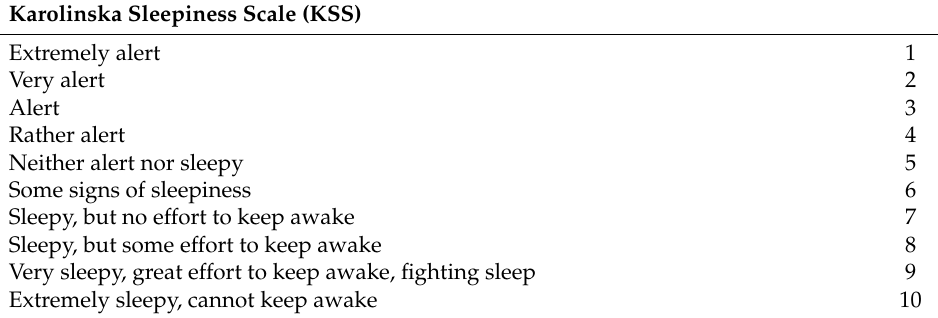
Table 2. Karolinska Sleepiness Scale